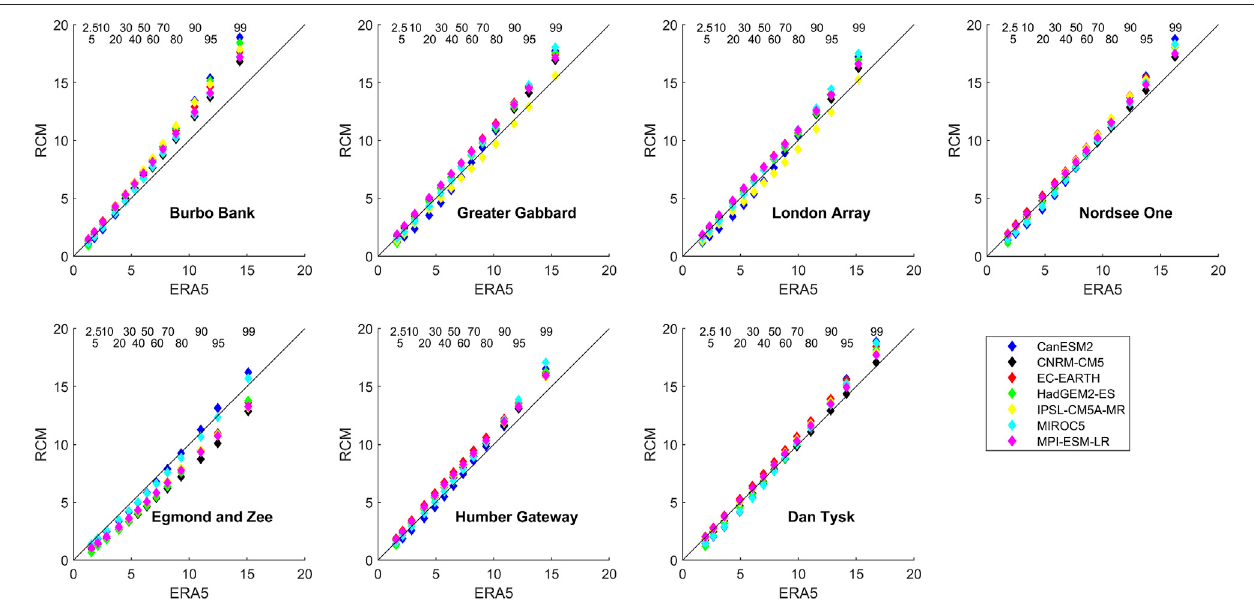
FIGURE7| Quantile-quantileplotsofthecomparisonbetweentheERA5andthesevenanalyzedregionalclimatesimulationsatthesevenoffshorewindfarms.The quantiles range from 2.5th to 99th, as indicated at the top of each